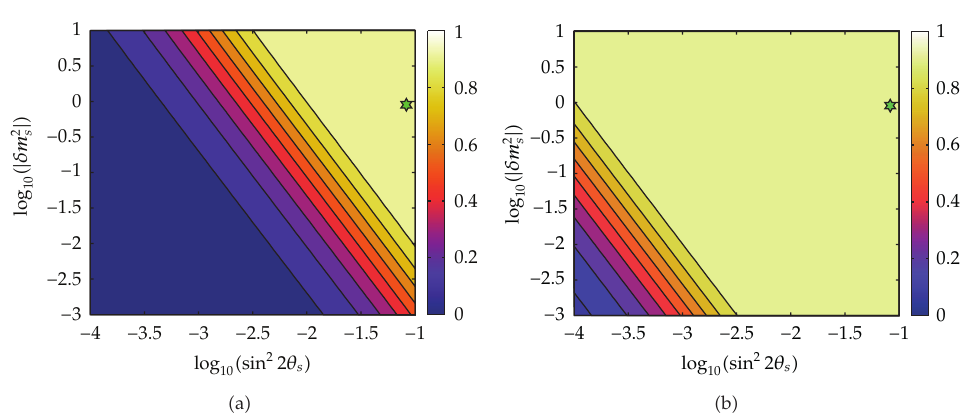
Figure 4: Isocontours of the final value of Δ N e ff in the sin 2 2 θ s - δm 2 s plane for vanishing lepton asymmetry and δm 2 s > 0 (cid:2) a (cid:3) and δm 2 s < 0 (cid:2) b (cid:3) . The star denotes the best-fit mixing parameters as in the 3 (cid:8) 1 global